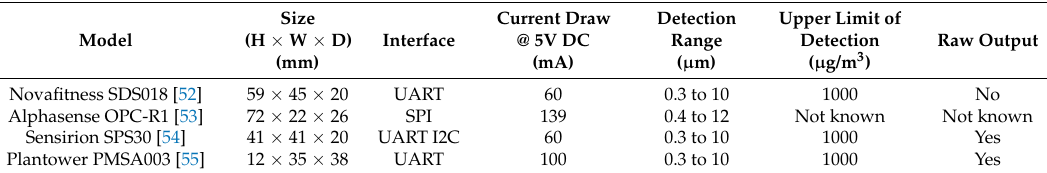
Table 8. Main characteristics of the fan assisted Particulate Matter (PM) sensors to be used in Version 2 Air Quality (AQ) Internet of Things (IoT) devices. Each AQ IoT device supports up to ten PM sensors and the configuration can differ between AQ IoT devices.